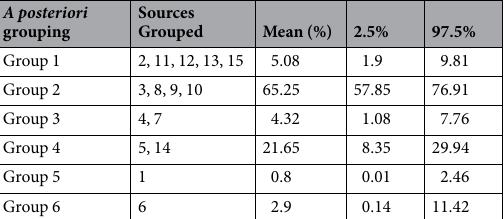
Table 4. Model output from theoretical example 2, indicating output after grouping a posteriori . Mean values (in %) are displayed alongside the 95% credible intervals for each